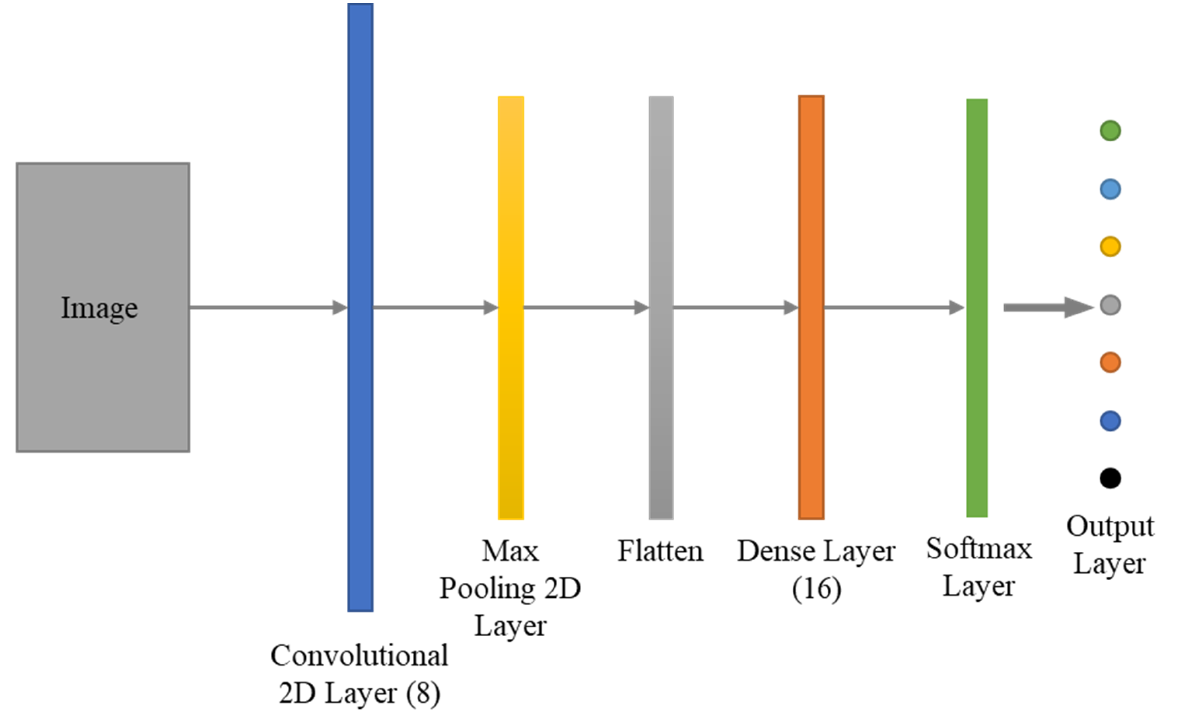
Figure 3. CNN architecture used in integrated OBIA-deep learning frameworks.